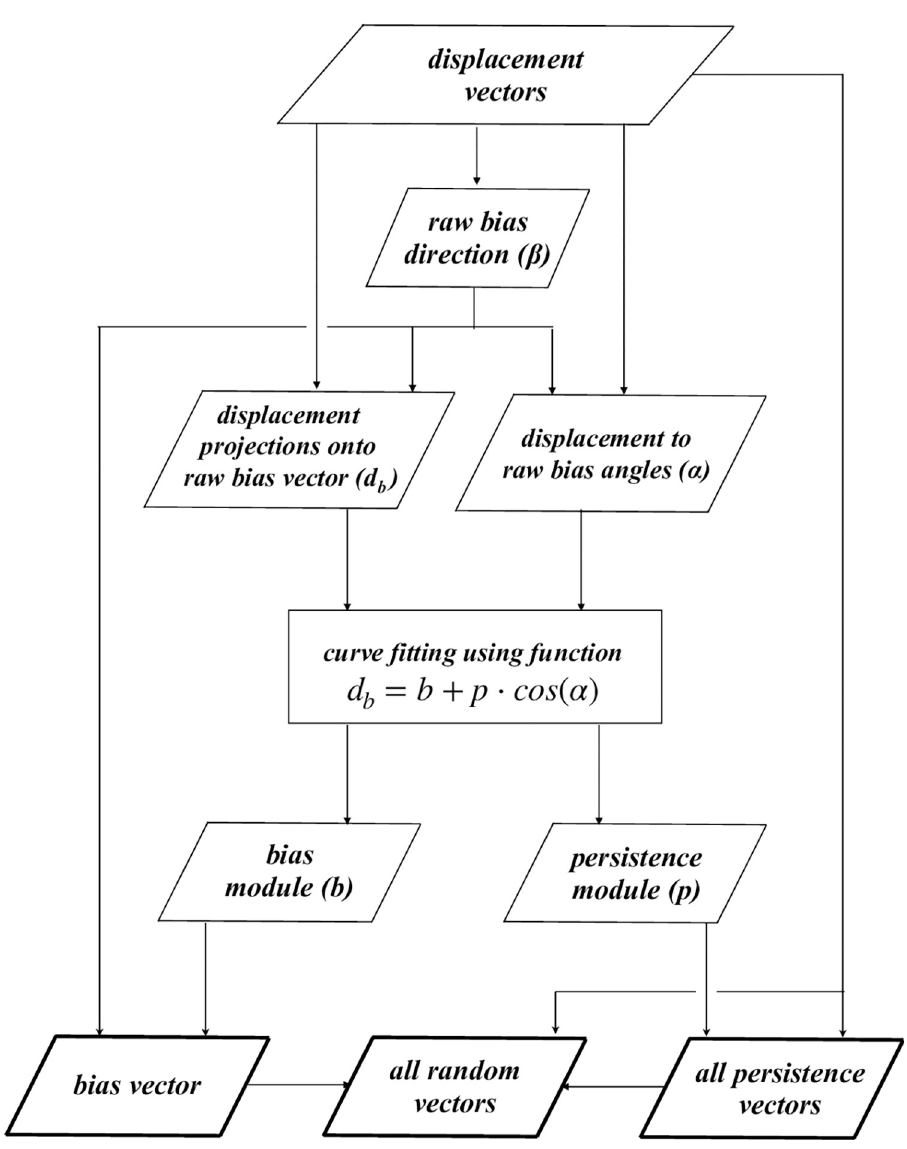
Fig 3. Schematic representation of the procedure for parameters evaluation. This figure schematically reports the procedure that, starting from displacement vectors, leads to the calculation of the bias vector, the persistence module and the list of the random vectors deprived of bias and persistence